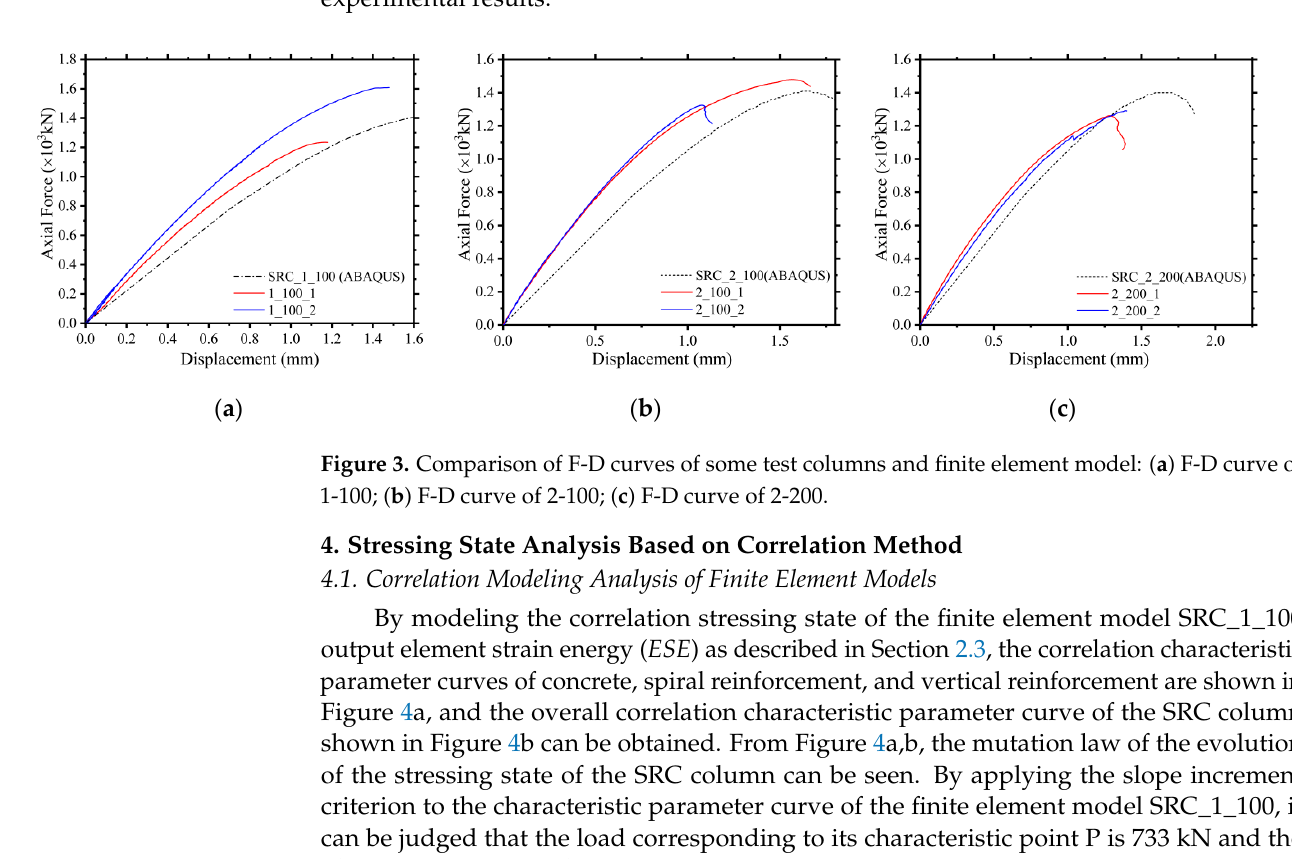
Figure 2. Meshing and element selection: ( a ) SRC column; ( b ) Concrete; ( c ) Vertical bar; ( d ) Spiral bar.